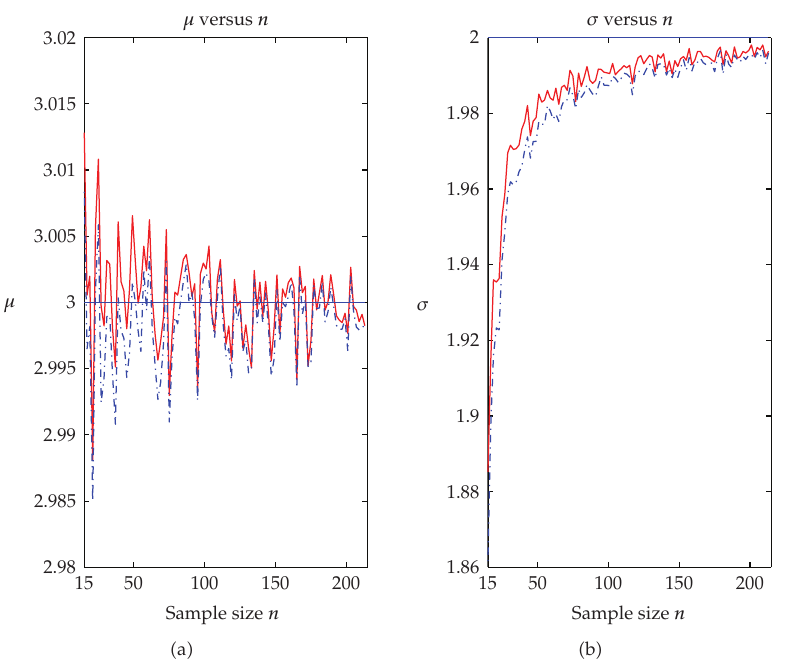
Figure 3: Grouped data: τ 1 (cid:8) 0, τ 2 (cid:8) 1 . 5, τ 3 (cid:8) 3, τ 4 (cid:8) 4 . 5, τ 5 (cid:8) 6. Type I left censored data: τ (cid:8) 0